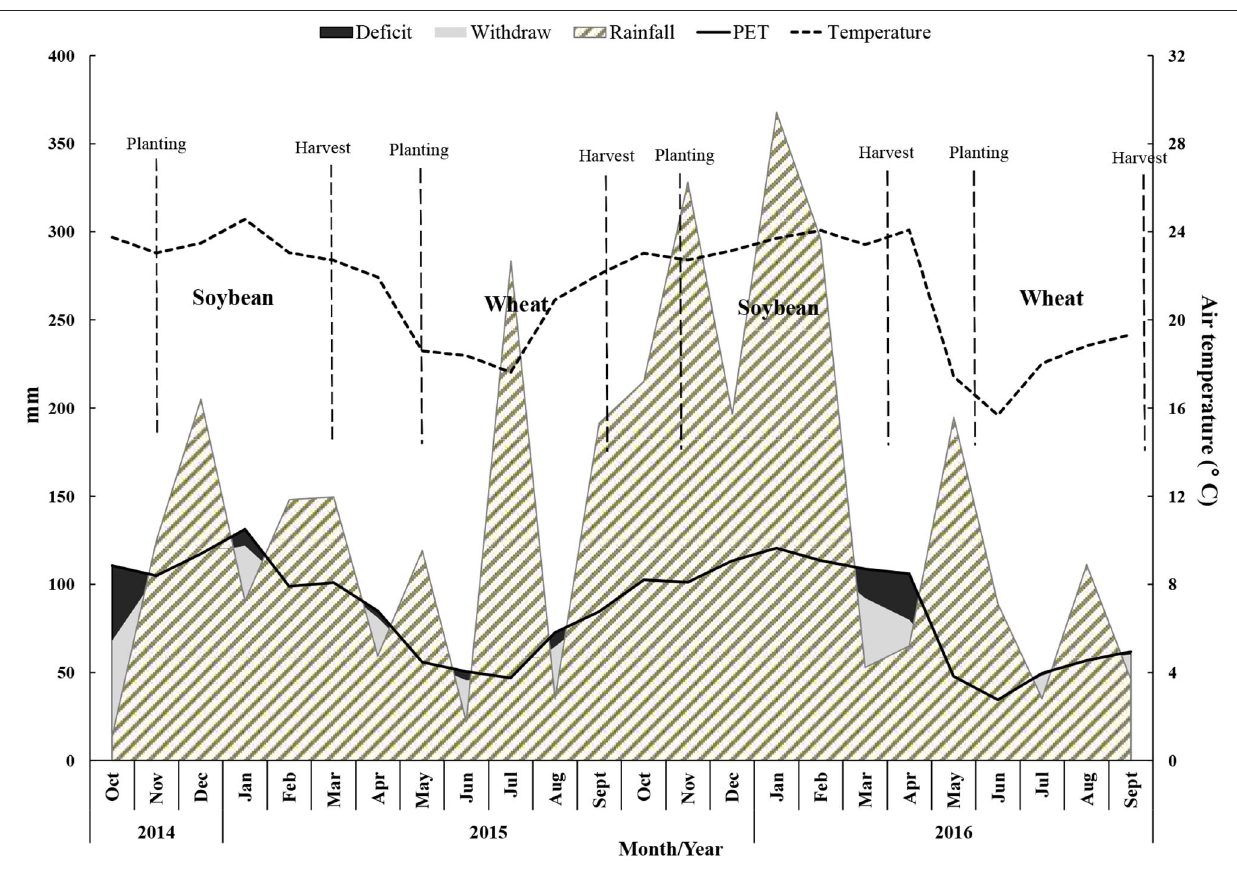
containing 20 g ha − 1 of molybdenum (Mo), 2.0 g ha − 1 of cobalt (Co), and 10 g ha − 1 of nickel (Ni). For the second soybean crop, in addition to the P 2 O 5 treatments, the experimental area